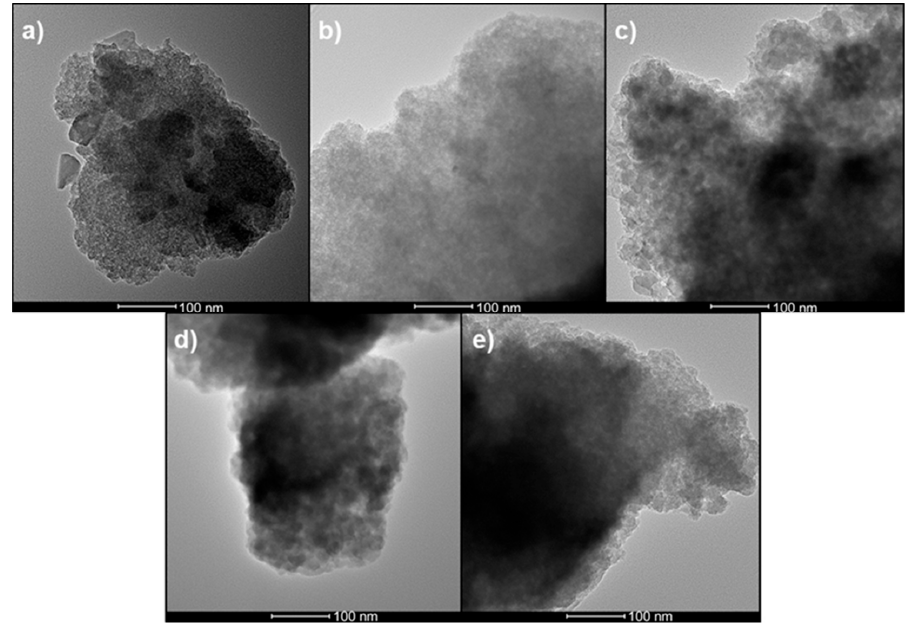
Figure 1. High resolution transmission electron microscopy (HRTEM) images of non-ordered mesoporous silicate glasses (MSGs): ( a ) Undoped-MSG; ( b ) 5 wt% Ag-MSG; ( c ) 5 wt% Cu-MSG; ( d ) 5 wt% Zn-MSG; ( e ) 5 wt% Ce-MSG. Scale bar = 100 nm.